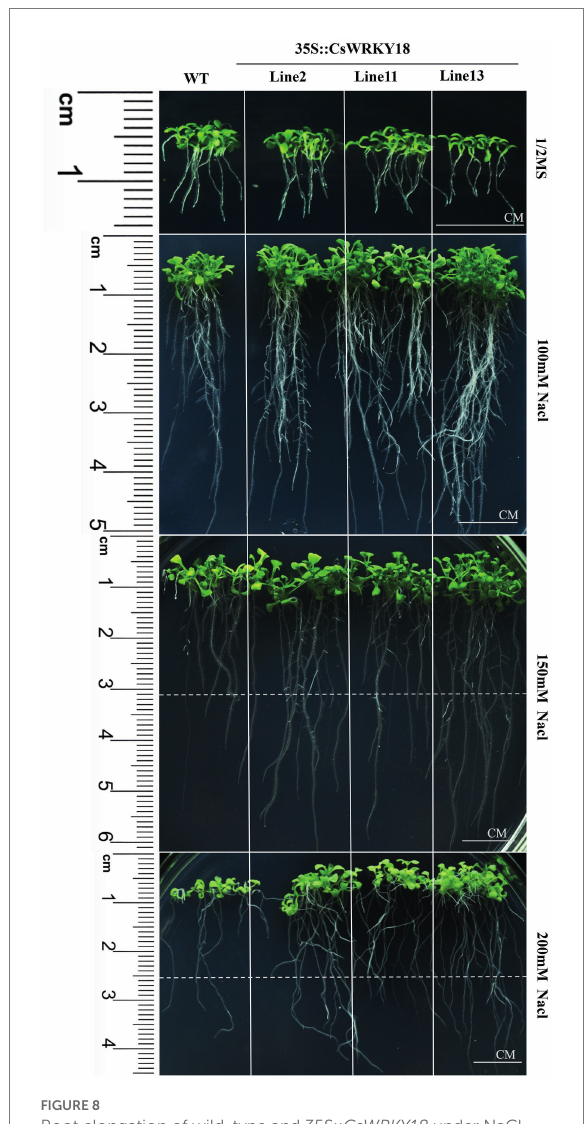
FIGURE 8 Root elongation of wild-type and 35S:: CsWRKY18 under NaCl treatment in 100, 150, and 200